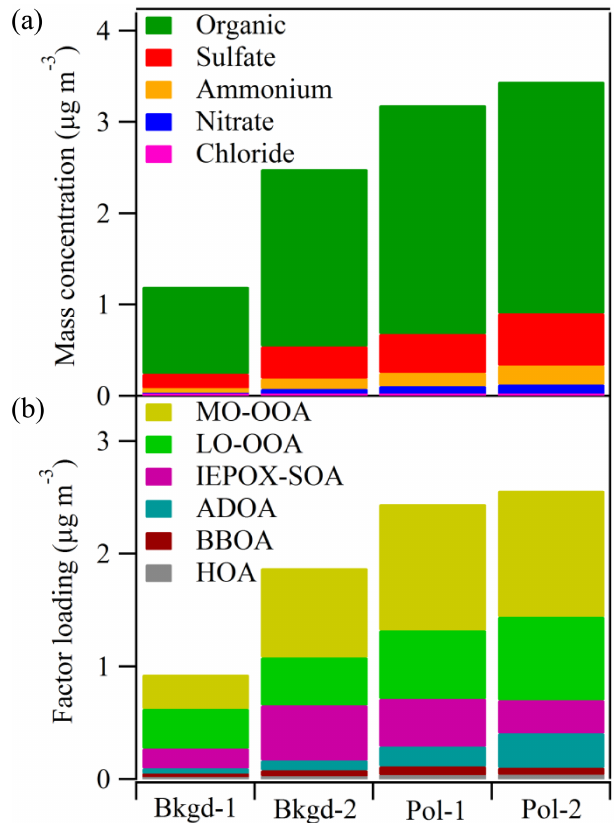
Figure 8. Characteristic PM composition of the FCM clusters as represented by coordinates of cluster centroids. (a) Mass concentra- tions of AMS species characteristic of each cluster. (b) PMF factor loadings characteristic of each cluster. Calculations are presented in more detail in the Supplement (Sect. S3). Values plotted are shown in Table